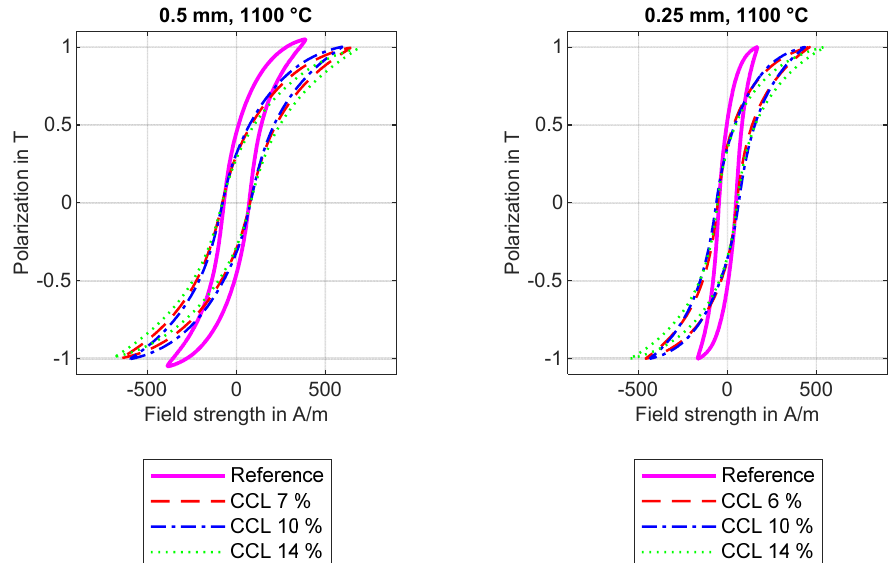
Figure 5. Hysteresis loops for square reference samples and composed strip samples at a frequency of 50 Hz. Left column: sheet thickness of 0.5 mm and annealing temperatures of 900 °C, 1000 °C and 1100 °C, respectively. Cutting clearance was 7%, 10% and 14%. Right column: sheet thickness of 0.25 mm and annealing temperatures of 900 °C, 1000 °C and 1100 °C. Cutting clearance was 6%, 10% and 14%.